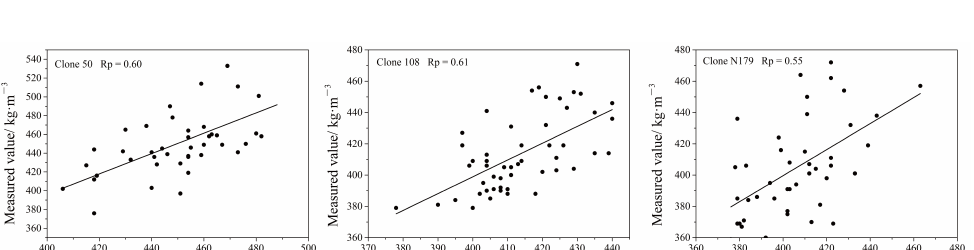
Figure 6. Correlation between the NIR predicted value and measured value of the air dry density of three